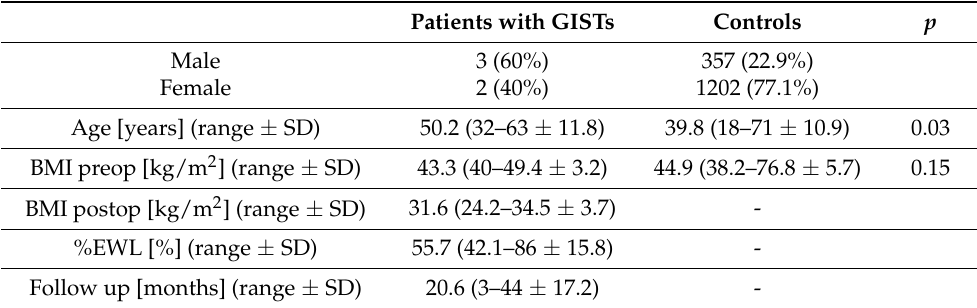
Table 1. Characteristics of patients with GISTs and controls. (BMI—body mass index;